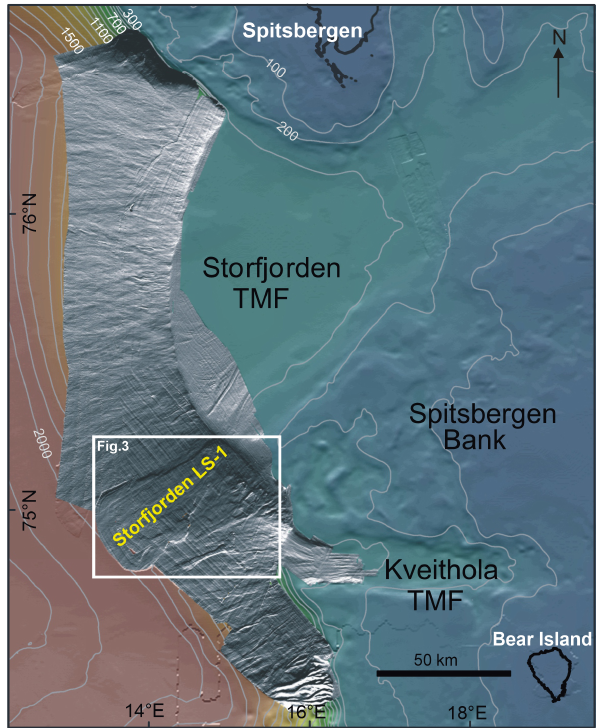
Figure 2. Shaded relief map from merging the regional dataset (colour map, 250m; Ottesen, 2005) and high-resolution datasets (grey map, 75m) of the Storfjorden and Kveithola TMFs, where the Storfjorden LS-1 landslide reaches full data